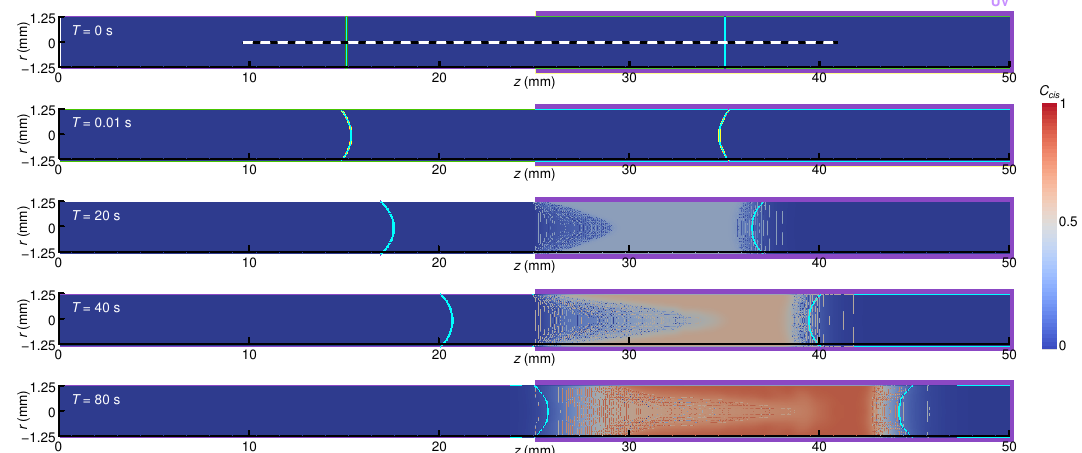
Figure 4. Cross-sectional views of the liquid column with a length of L c = 20 mm and the developing distribution of the ratio of the cis isomer, C cis , during the droplet migration driven by photoisomerization by a partial UV-light irradiation, at time instances of 0, 0.01, 20, 40, and 80 s (from top to bottom). The tube radius is R = 1.25 mm. Contour shows the ratio of the cis isomer: C cis = 1, all cis isomers; C cis = 0, all trans isomers. Cyan solid lines indicate the liquid–air interface positions; purple-colored backgrounds (on the right half of the domain) represent the UV-light irradiated parts.